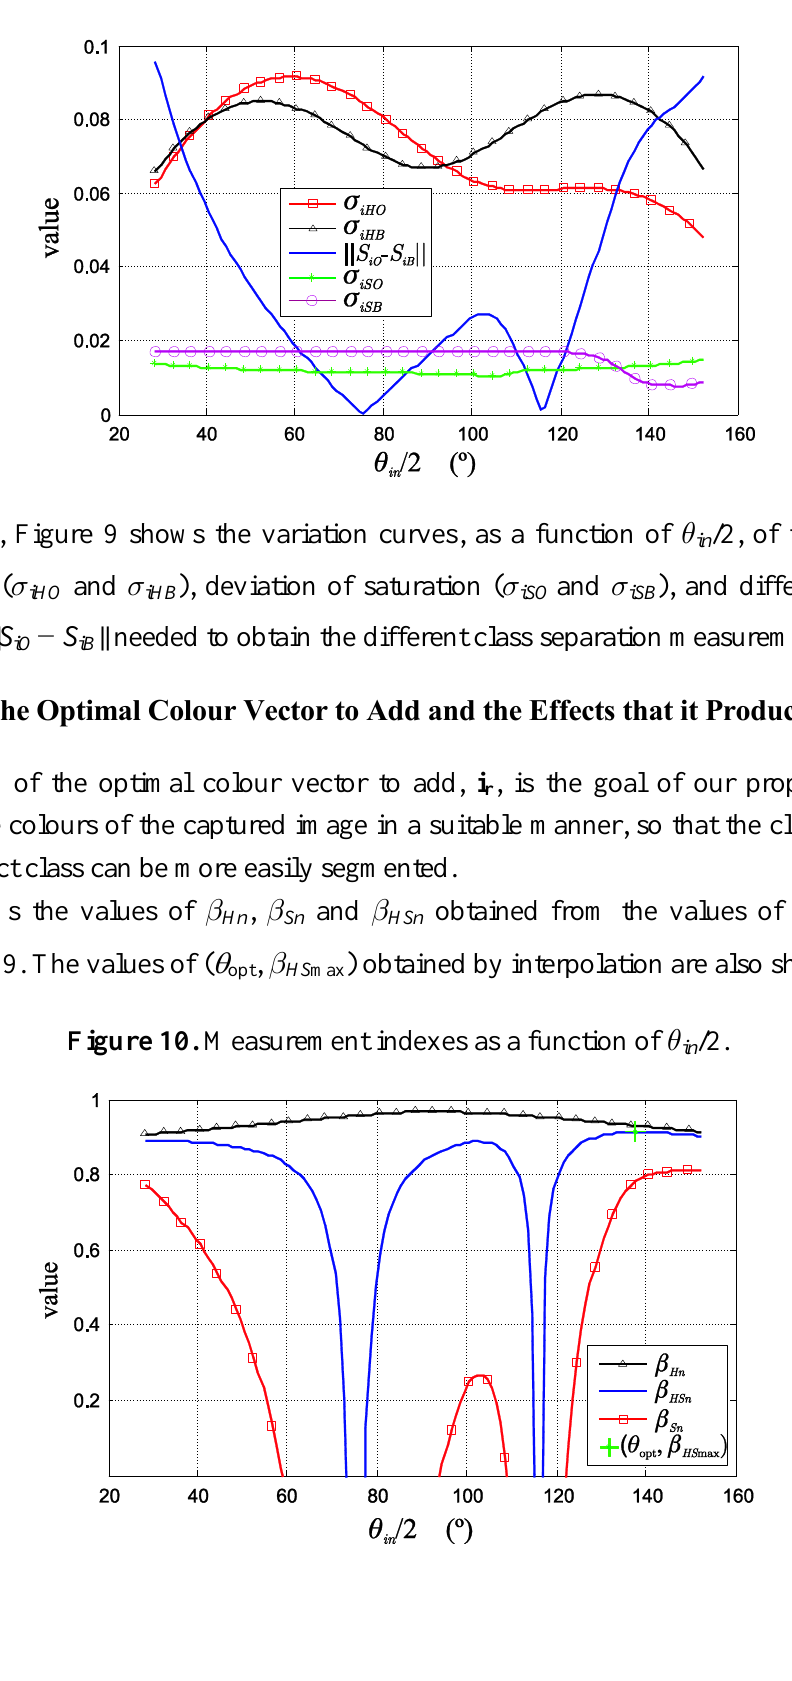
/2. The difference in